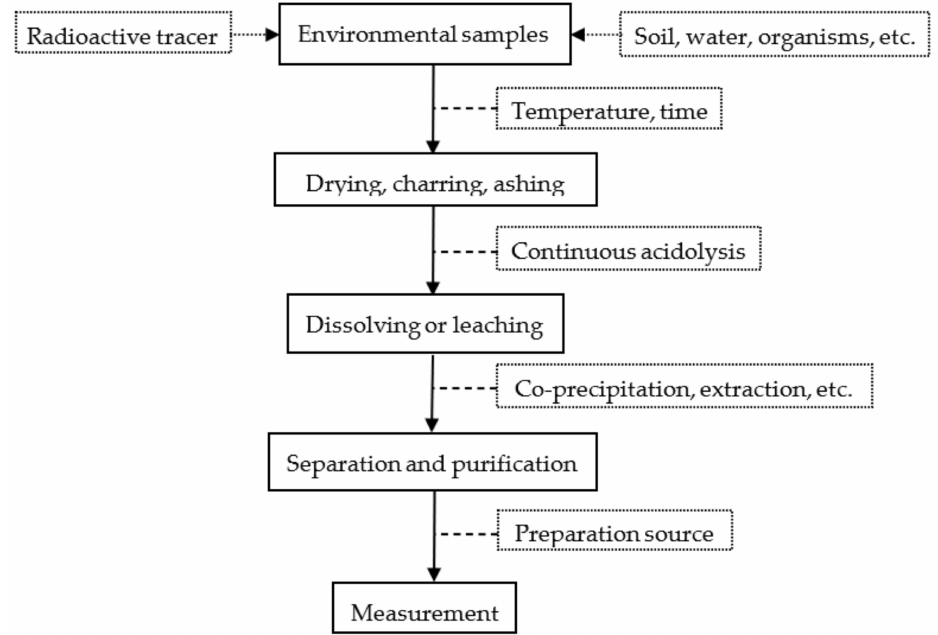
Figure 1. Separation process of radionuclides in environmental